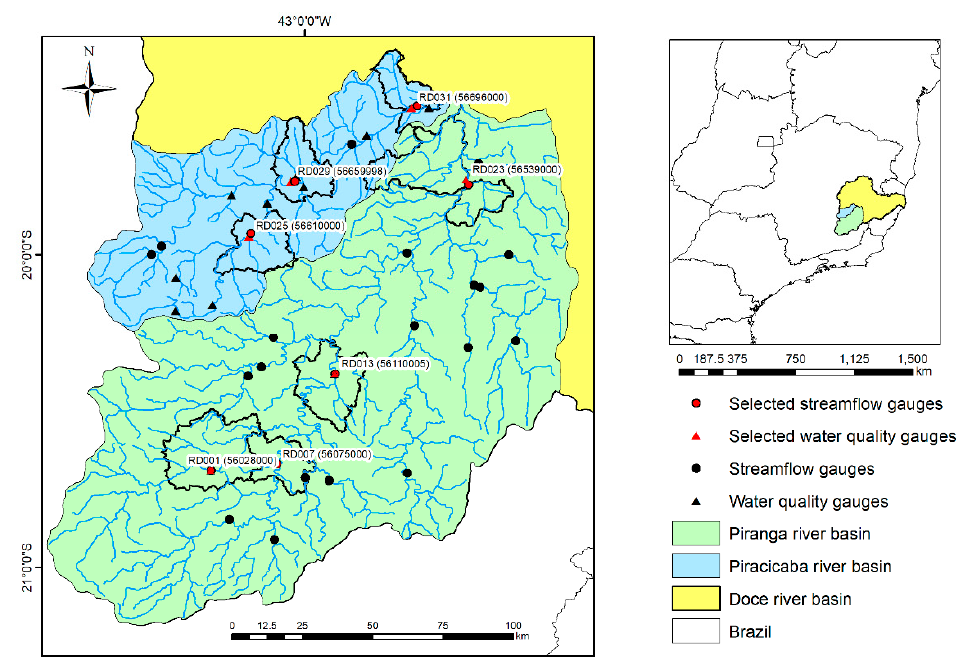
Figure 1. Identification and location of the studied basins, with the plot of streamflow and water quality gauges selected for this study.